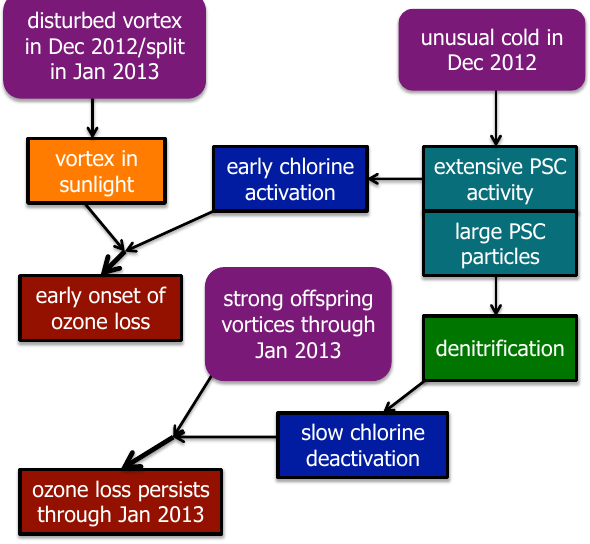
Figure 15. Block diagram of the processes leading to unusual early- winter chemical ozone loss in 2012/13. Purple boxes show the key dynamical processes that, in combination, resulted in the unusual early-winter chemical processing. Blue-green and blue boxes show PSC and chlorine processes, respectively. Orange box indicates sun- light exposure and green box denitrification. Both phenomena going into each dark red box were necessary for the chemical ozone loss to take